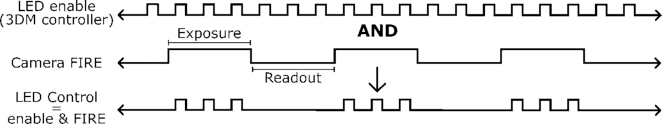
Illumination trigger signal logic. This logical operation occurs for each illumination wavelength at the rightmost AND gates pictured in Fig. 2.